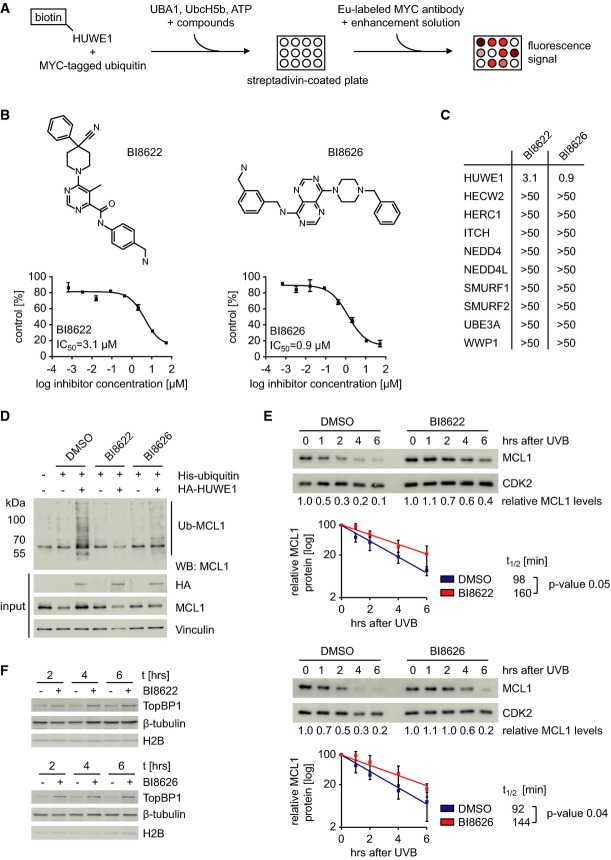
Identification of small molecule inhibitors of HUWE1Scheme of the high-throughput screen for identification of small molecule HUWE1 inhibitors.The upper panels show the structures of BI8622 and BI8626. The lower panel displays the
corresponding IC50 curves of compounds BI8622 and BI8626. The curves are presented as
mean ± SD (n = 2).Table of the IC50 values for BI8622 and BI8626 in in vitro
ubiquitination assays with HUWE1 and other HECT E3 ubiquitin ligases.In vivo ubiquitination of MCL1. HeLa cells were transfected with plasmids
expressing MCL1, His-ubiquitin, and HA-HUWE1. Where indicated, cells were treated with compounds
BI8622 and BI8626 or DMSO as solvent control. After lysis, ubiquitin-modified proteins were
recovered by Ni-NTA-Agarose and immunoblots of the eluates were probed with an antibody against
MCL1. The input control shows 1% of the total lysate.UV-induced degradation of MCL1 after HUWE1 inhibition. U2OS cells were treated with BI8622 (upper
panel) or BI8626 (lower panel) or DMSO as control. At the same time, cells were irradiated with 500
J/m2 UVB and harvested after indicated time points. Immunoblots of the lysates were
probed with antibodies recognizing either MCL1 or CDK2 as control. Quantification of the MCL1
protein levels for the according experiment is shown directly below the immunoblots. Diagrams below
the immunoblots show mean protein levels ± SD (n = 5).
From the data, the half-life of the MCL1 protein was determined with P-values
calculated using a Student's t-test.Effects of HUWE1 inhibition on levels of TopBP1. Ls174T cells were treated with BI8622 and BI8626
or DMSO (−) as control for the indicated time points. Cell lysates were fractionated in
chromatin-bound and soluble non-chromatin-bound fractions. Immunoblots of the soluble fraction were
incubated with indicated antibodies.